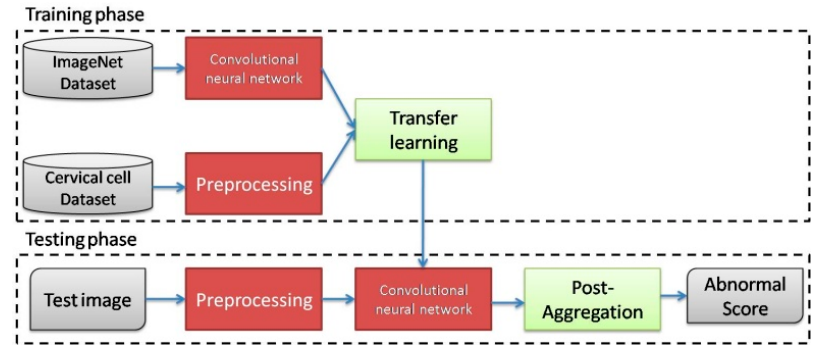
Figure 3. The total structure of the cervical cancer detection method in [11].